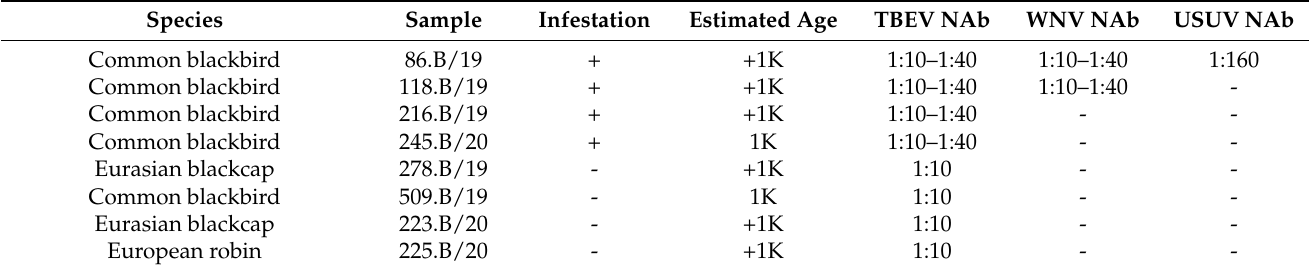
Table 4. Determination of flavivirus infections by simultaneous µ